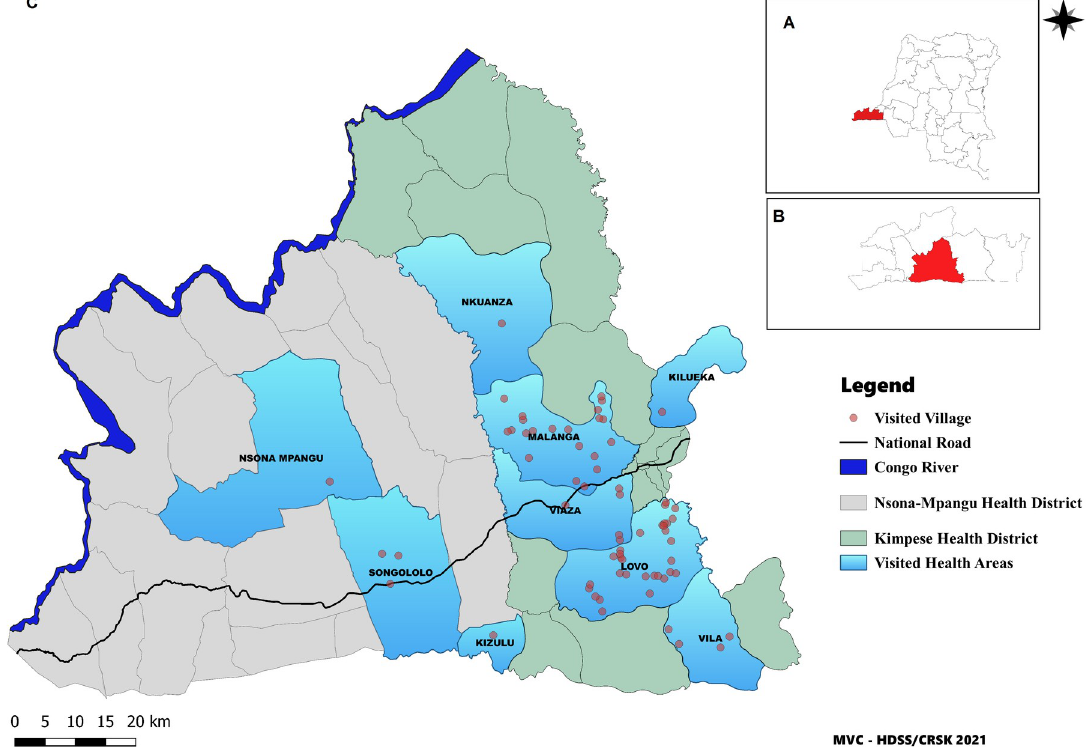
Fig 1. Map of the study area in Kongo Central Province: A: The Democratic Republic of the Congo with Kongo Central province highlighted. B: Kongo Central province, the study area highlighted. C: Map of Nsona Mpangu and Kimpese district showing all visited villages. Map created using QGIS 3.16 based on https://www.naturalearthdata.com/downloads/10m-cultural-vectors/ and https://www. diva-gis.org/gdata.